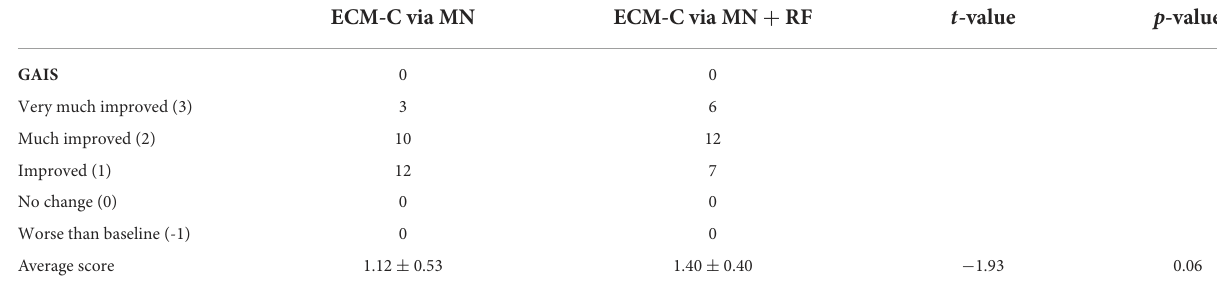
TABLE 5 GAIS assessment by the study participants.